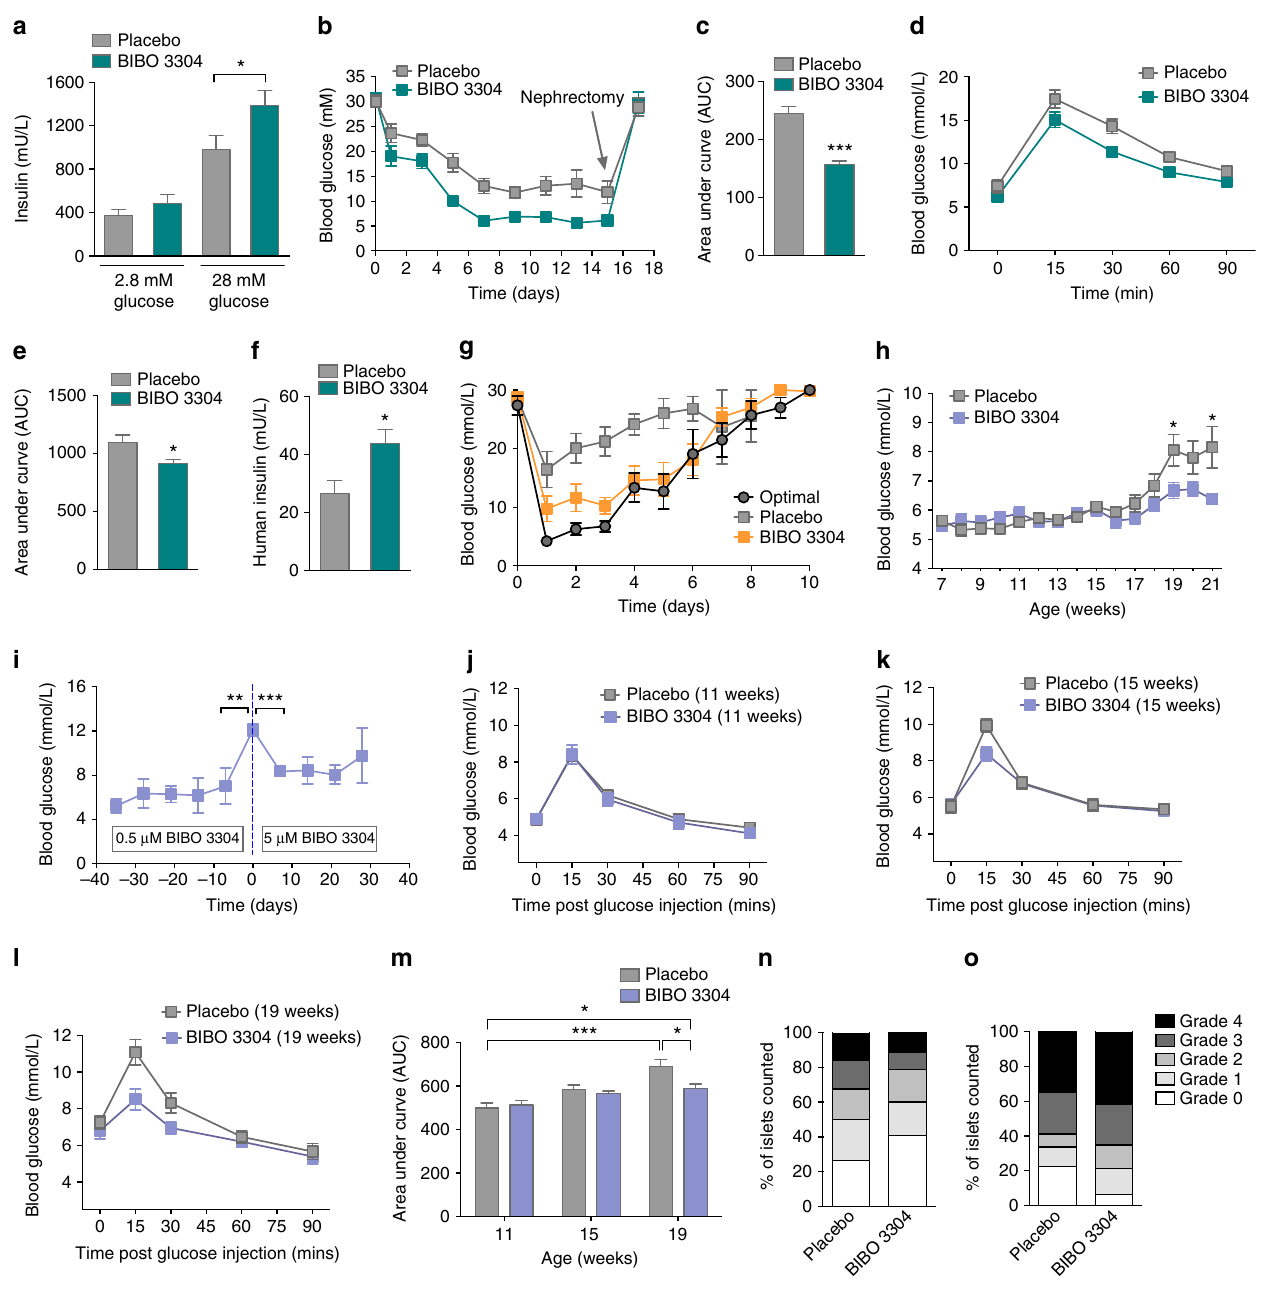
Fig. 3 Improved human islet transplant outcomes due to Y1 receptor antagonism. a Human islets from three independent donors were isolated and cultured for 48 h. Insulin secretion from human islets was determined in response to 2.8 and 28 mM glucose with or without 1 μ M BIBO3304 ( n = 3; triplicate; three independent donors). b , c Alloxan-induced NOD RAG1 − / − diabetic mice were transplanted with human islets (IEQ 1400) and subsequently orally treated with or without 0.5 μ M BIBO3304 and blood glucose levels were monitored for 15 days after which survival nephrectomy was performed ( n = 7 per group; two independent donors). Results are also expressed as area under the curve. d , e Human islet recipient mice treated with placebo or 0.5 μ M BIBO3304 for 7 days ( n = 4) were fasted for 6 h and i.p. glucose tolerance tests (1 g/kg body weight) were performed. Results were also expressed as area under the curve. f Serum insulin levels in human islet recipient mice were determined at day 15 post-transplantation ( n = 7). g Alloxan-induced diabetic mice were transplanted with a full MHC mismatch (BALB/c islet − > C57BL/6) optimal number of allogeneic islets (300) ( n = 6) or 60 allogeneic islets ( n = 14) and treated daily with either 0.5 μ M BIBO3304 ( n = 6) or placebo (n = 8). h 6-week-old female NOD mice were treated with placebo or 0.5 μ M BIBO3304 daily and glucose levels monitored weekly ( n = 16 per group). i When the blood glucose levels in BIBO3304-treated mice eventually also reached 12 mM, a 10-fold higher dose of BIBO3304 was given in an attempt to reverse the hyperglycemia ( n = 3). j , k , l Glucose tolerance tests were performed in BIBO3304-treated and placebo-treated NOD mice at 11, 15, and 19 weeks of age, respectively ( n = 6 per group). m Results were also expressed as area under the curve. n , o Insulitis was scored on islets from NOD mice either treated with 0.5 μ M BIBO3304 or placebo at 12 or 22 weeks of age ( n = 6, n = 5), respectively. Data are means ± s.e.m. * P < 0.05, ** P < 0.01; *** P < 0.001 calculated by t -test ( a , c , e , f ) or two-way ANOVA